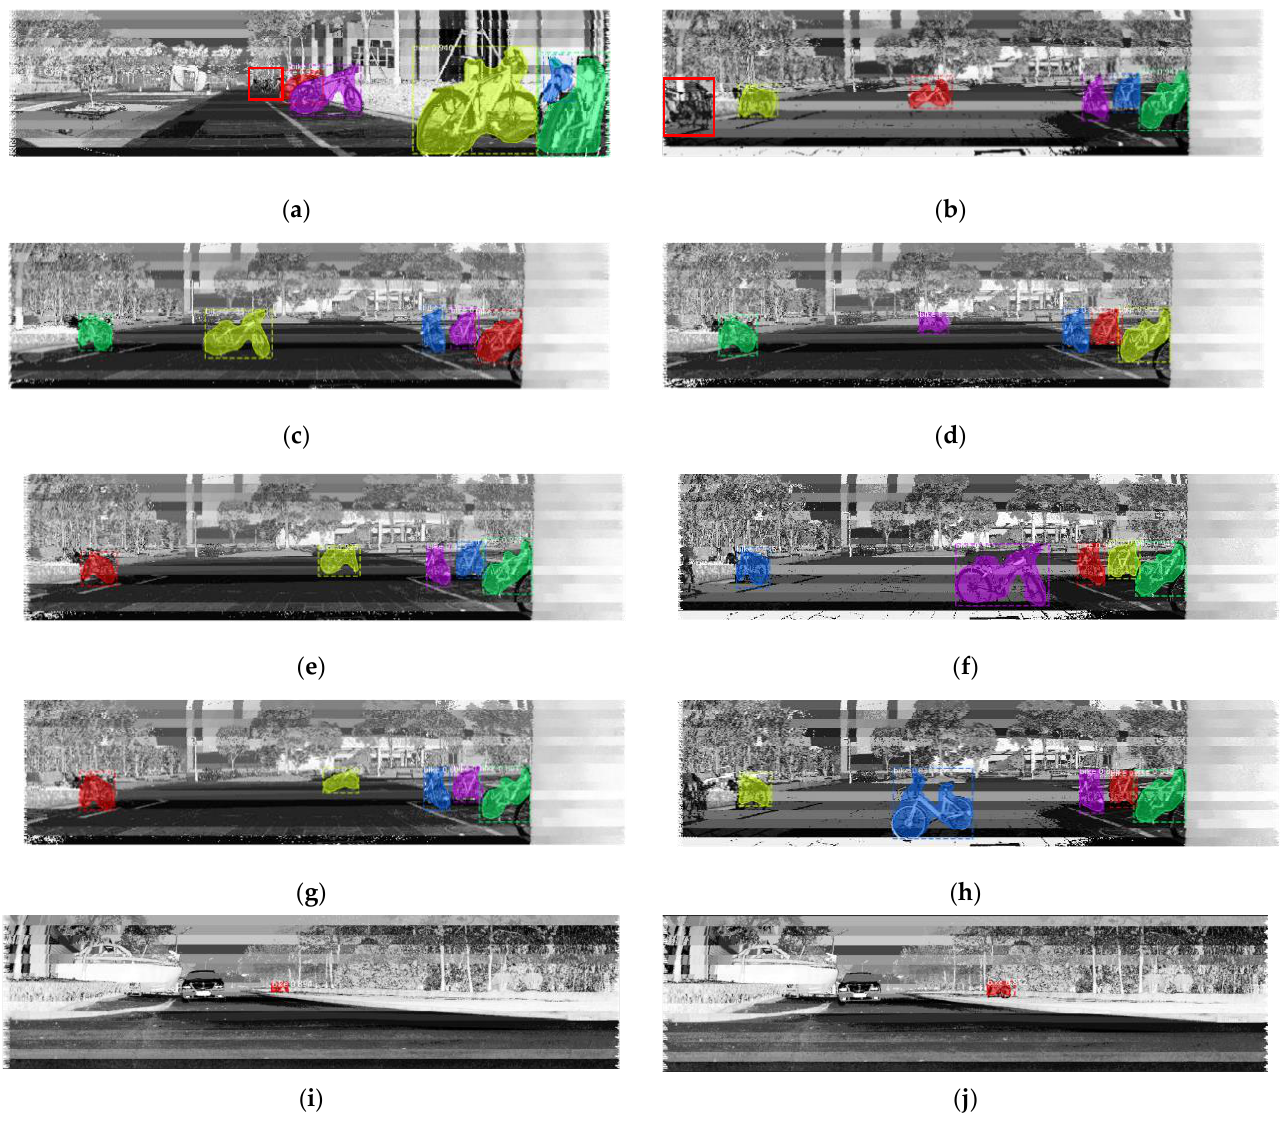
Figure 22. The results of bike recognition and 2D segmentation with Mask-RCNN: ( a – j ) the corre- sponding recognition results of ten scenes in Figure 21.